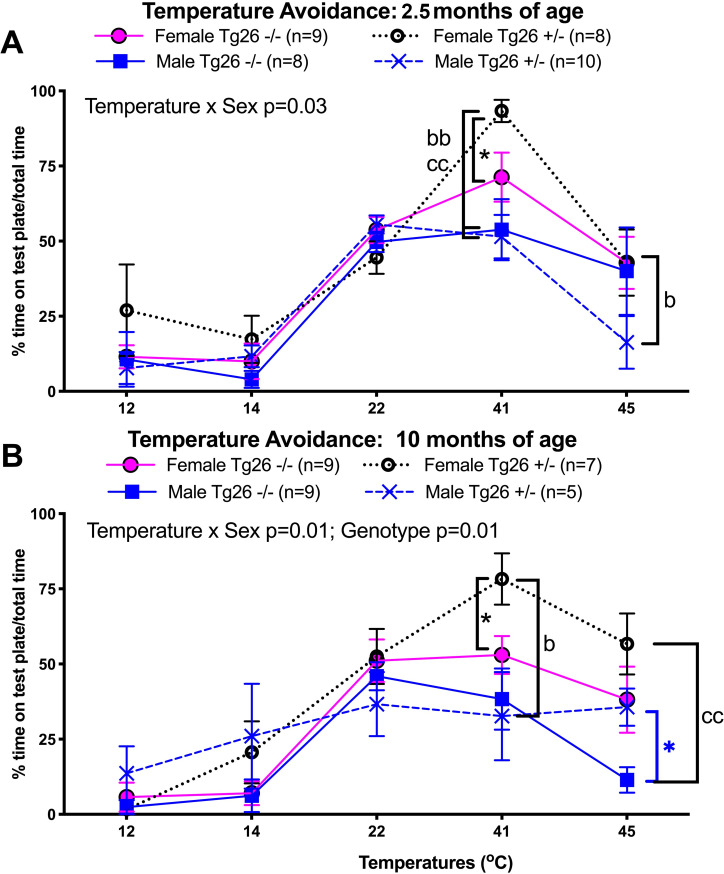
Temperature sensitivity/aversion, assayed using a two-plate temperature place preference testing instrument at 2.5 and 10 months of age, in wild-type mice -/- and heterozygous Tg26 +/- mice of both sexes.(A) Results when tested at 2.5 months of age. (B) Results when tested at 10 months of age. Mean ± SEM shown. *: p<0.05, compared to wild type -/- mice of same sex; b and bb: p<0.05 and p<0.01, compared to opposite sex of same genotype (opposite sex); cc: p<0.01, compared to opposite sex of opposite genotype (opposite sex and genotype). Number of animals per sex, genotype and age, are indicated in the keys of panels A and B.